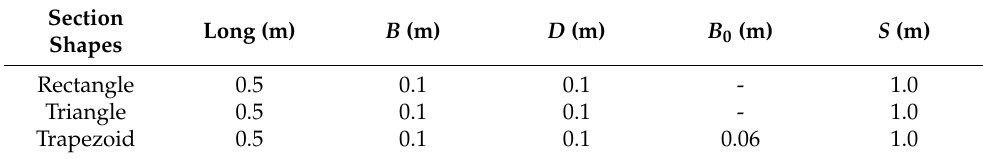
Table 1. Size of porous submerged breakwaters.